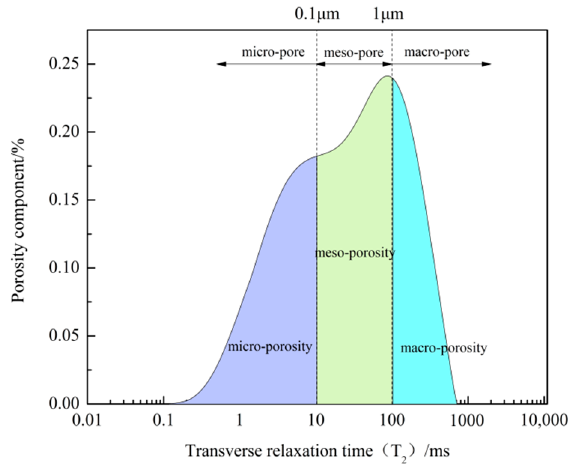
Figure 4. Diagram presents pore size distribution on the T 2 spectrum curve.